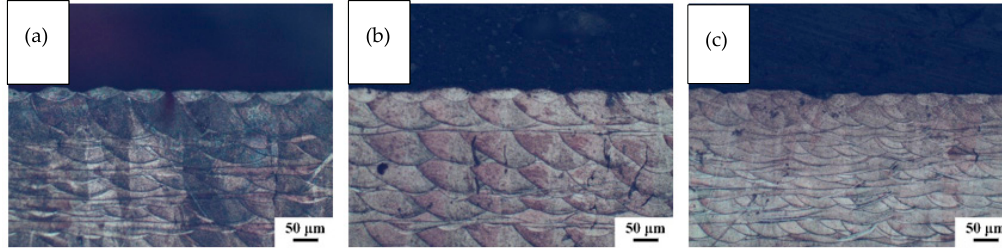
Figure 7. The metallographic structure of the samples at different scanning speeds: ( a ) 700 mm/s; ( b ) 900 mm/s; ( c ) 1100 mm/s.